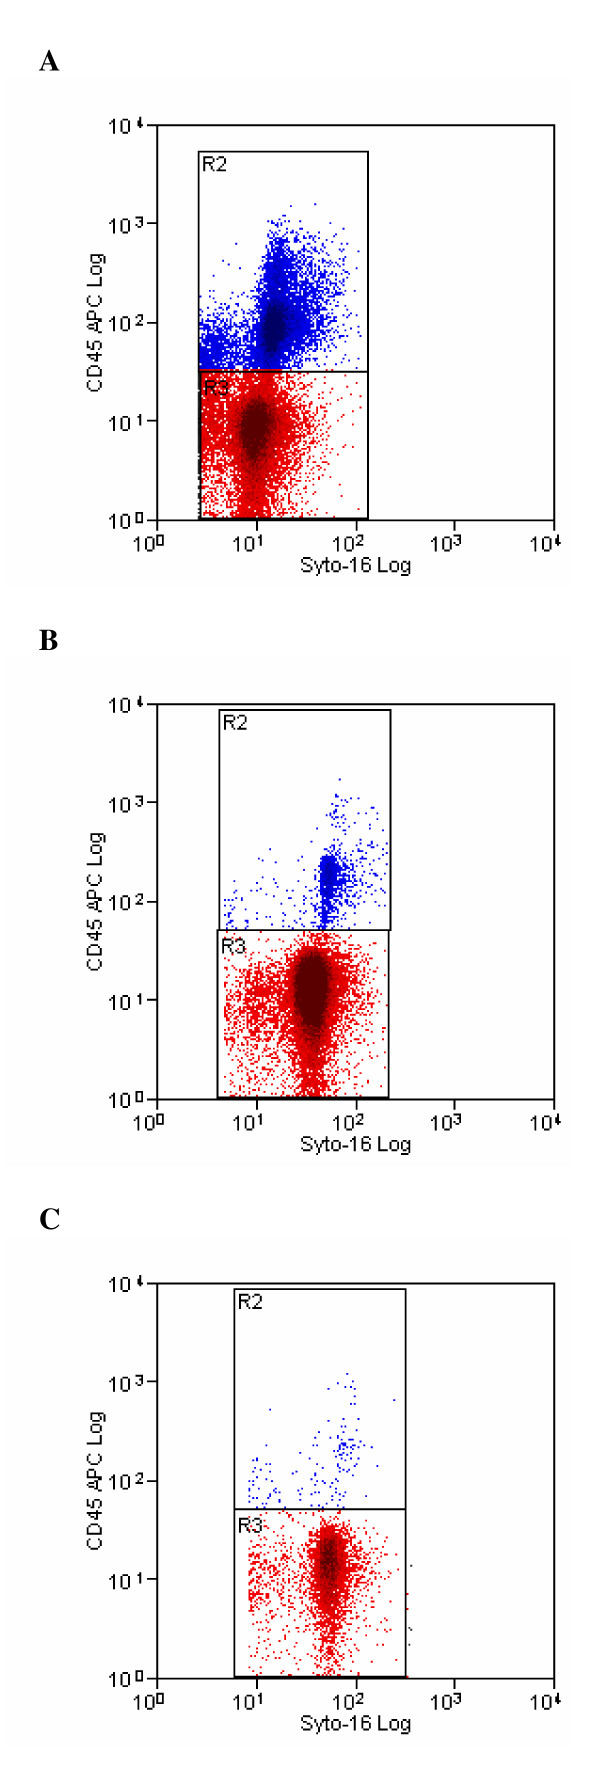
Pre- (4a) and post-processing (4b, 4c) cytofluorimetric analysis of a semen sample with a high leukocyte concentration. Cytogram 4a displays the cytofluorimetric analysis of a semen sample containing a high concentration of leukocytes moderate, stained with Syto-16 and CD45 to identify sperm and leukocytes. Region R2 (blue colour) and Region 3 (red colour) represent the number of leukocytes and sperm counted, respectively. Cytograms 4b and 4c displays the cytofluorimetric analysis of the same sample after density-gradient centrifugation and after swim-up technique, respectively.